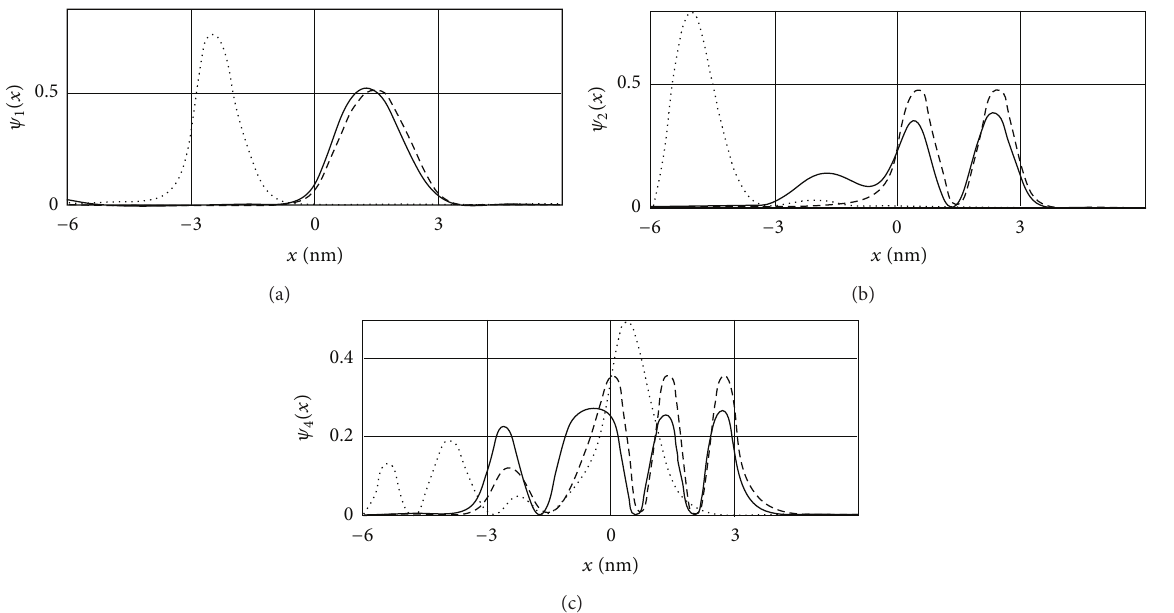
Figure 5: Wave functions for a complex relief (zero 𝐸 -field—dashed line, and 𝑞𝐹 = 0, 1 —solid line, 𝑞𝐹 = 1 —dotted line) for 𝑛 = 1 (a), 𝑛 = 2 (b), and 𝑛 = 4